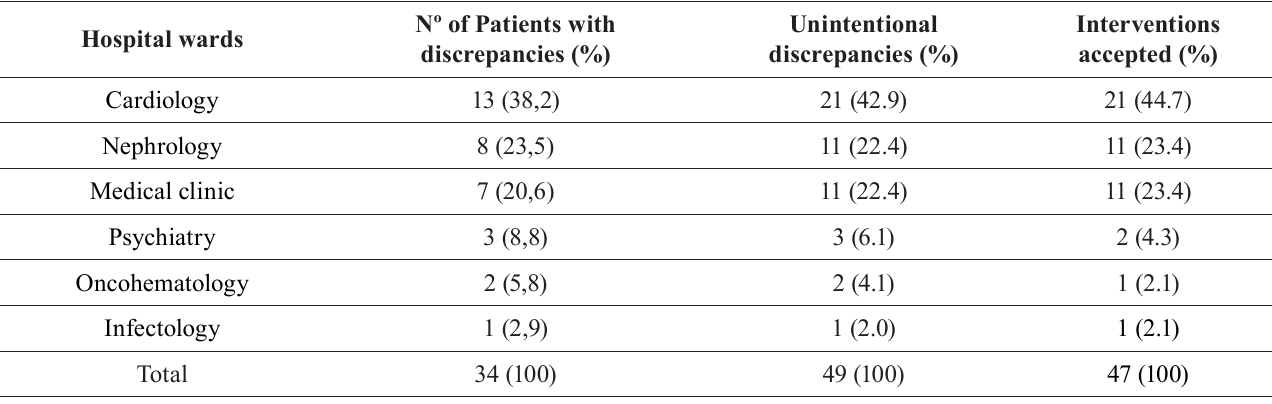
TABLE II - Number of Patients with unintentional discrepancies, and interventions accepted by hospital